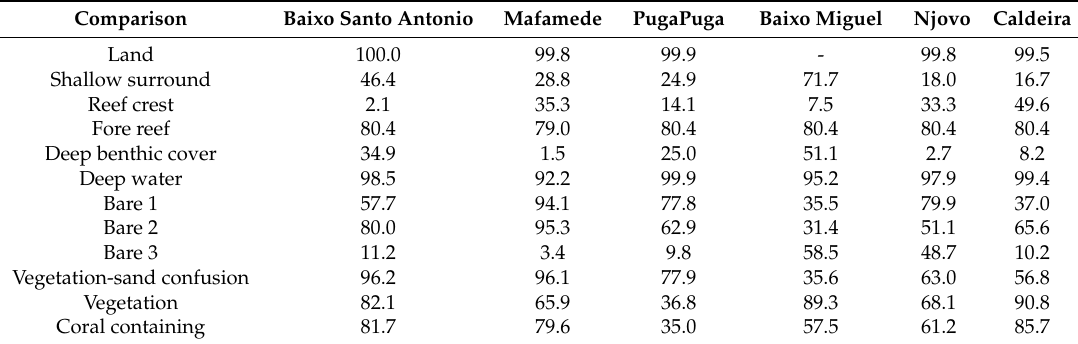
Table 8. Class agreement matrix results for selected pairs of classes.